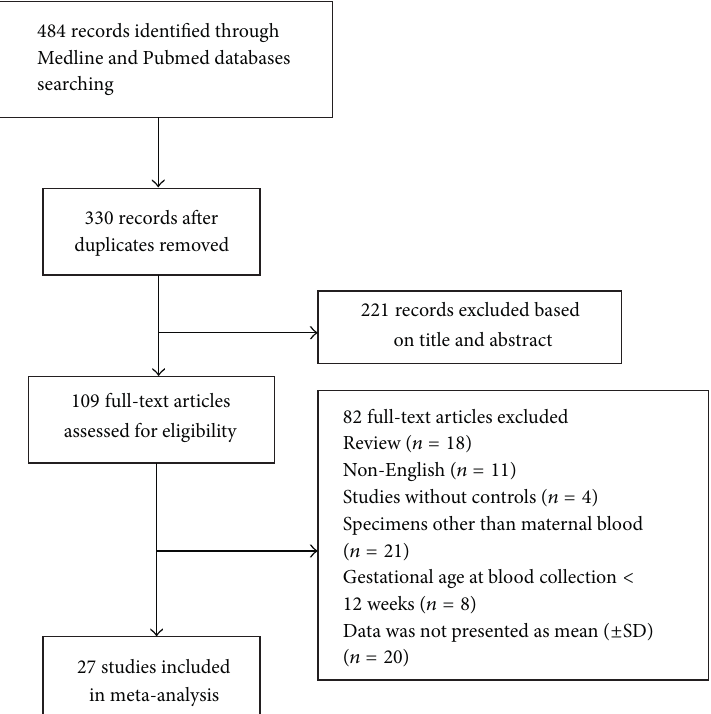
Figure 1: Flow diagram of the selection and systematic review of